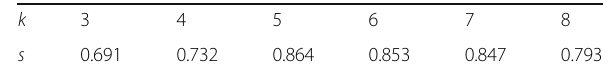
Table 2 Parameter selection process